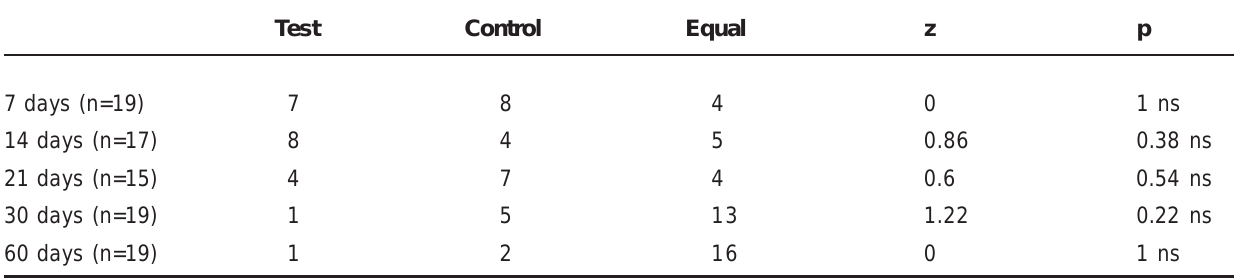
TABLE 1 - Number of patients with the best pattern of healing according to examiners’